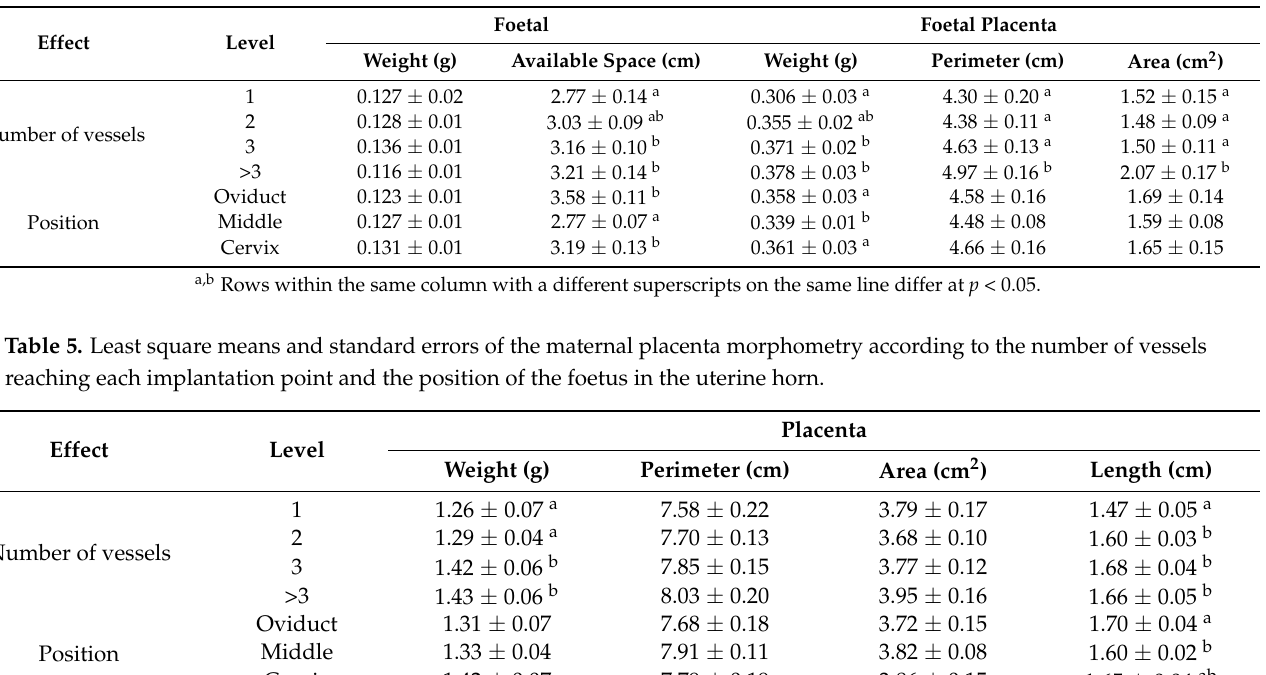
Table 4. Least square means and standard errors of foetal weight, available uterine space per foetus and foetal placenta morphometry according to the number of vessels reaching each implantation site and the position of the foetus in the uterine horn.